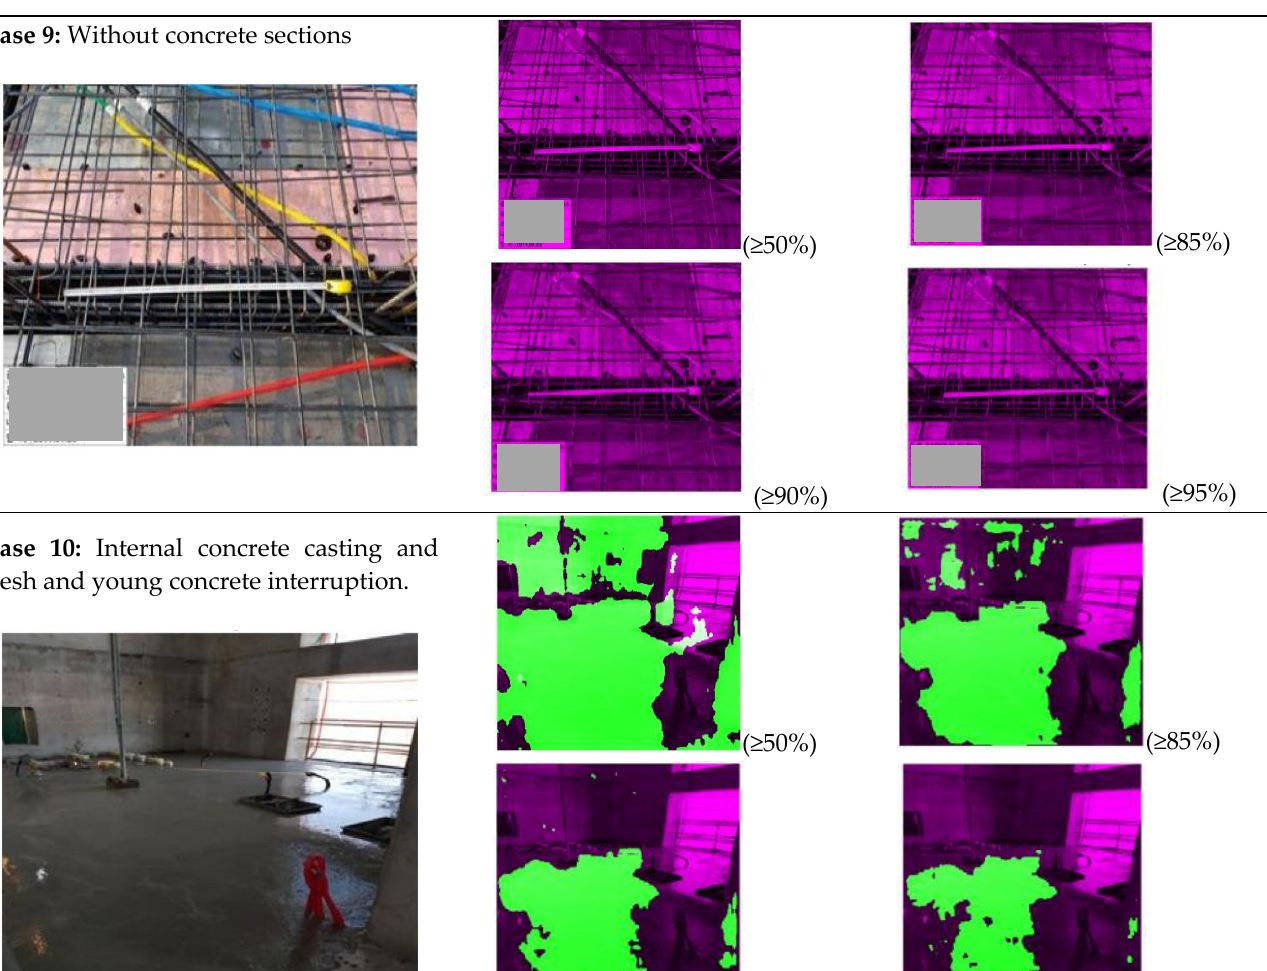
Figure 9. Examples of segmented images from the thresholding approaches (bright green: concrete; deep purple: noncon- crete).